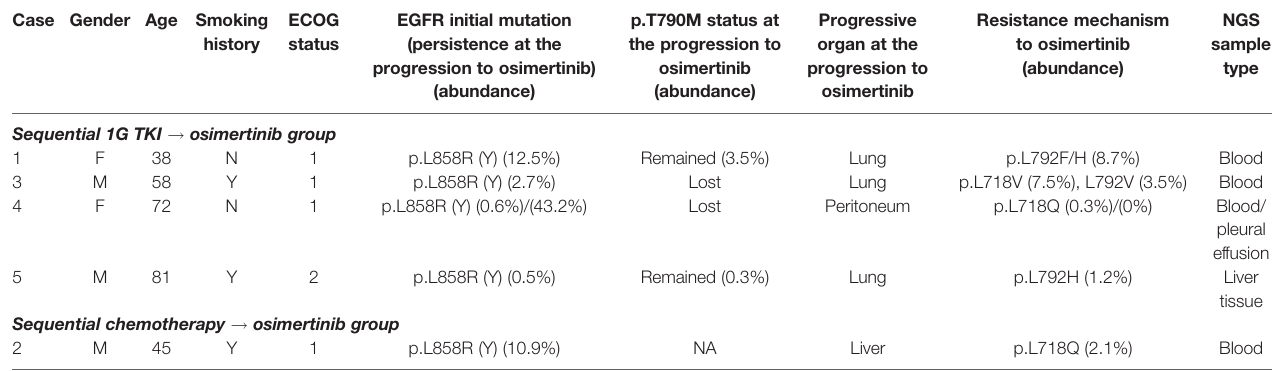
TABLE 1 | Patients characteristics and EGFR mutation pro fi